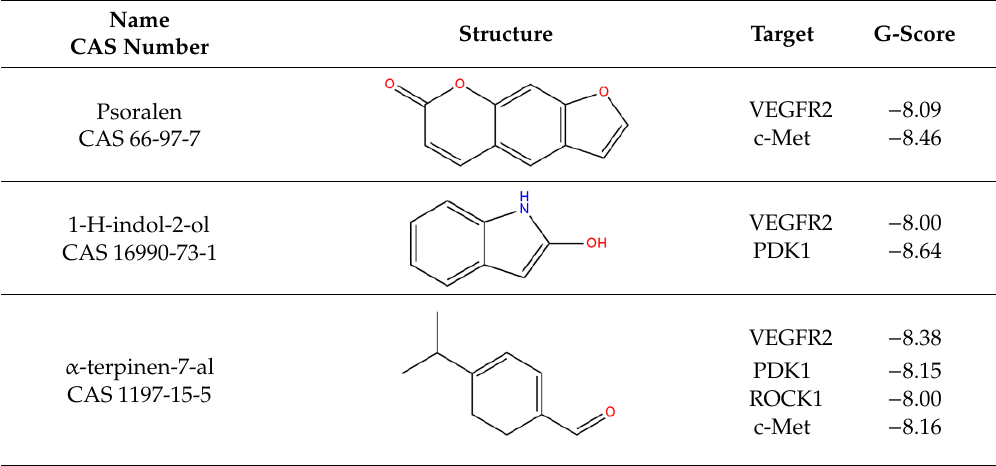
Table 1. Name, CAS (Chemical Abstracts Service) number and 2D structure of essential oils (EOs) components selected after Structure-Based Virtual Screening (SBVS) are shown together with the Protein Kinases targets and their related best theoretical affinities (G-score in kcal/mol).